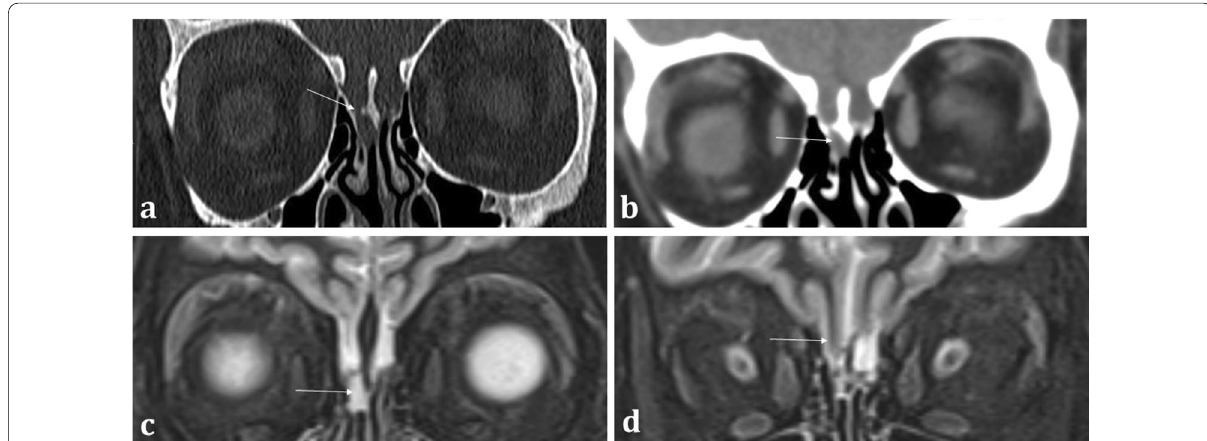
Fig. 15 Acquired post-traumatic CSF fistulas in two different patients. Coronal bone ( a ) and soft tissue ( b ) CT images demonstrate a tiny bony defect of the right cribriform plate (arrow, a ) and abnormal opacification of the right olfactory recess on the soft tissue window (arrow, b ). The coronal T2WI MRI image of the same patient confirms herniation of fluid intensity CSF into the right olfactory recess consistent with a meningocele (arrow, c ). For comparison, coronal T2WI MRI image of another patient ( d ) demonstrates herniation of both the gyrus rectus and CSF consistent with a meningoencephalocele (arrow, d )